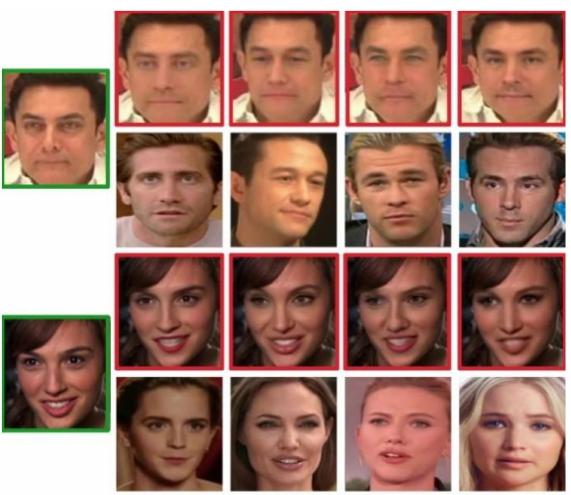
Figure 10. Samples from Celeb-DF dataset where the green images are the real faces and the red are generated fakes using the actors beneath them.